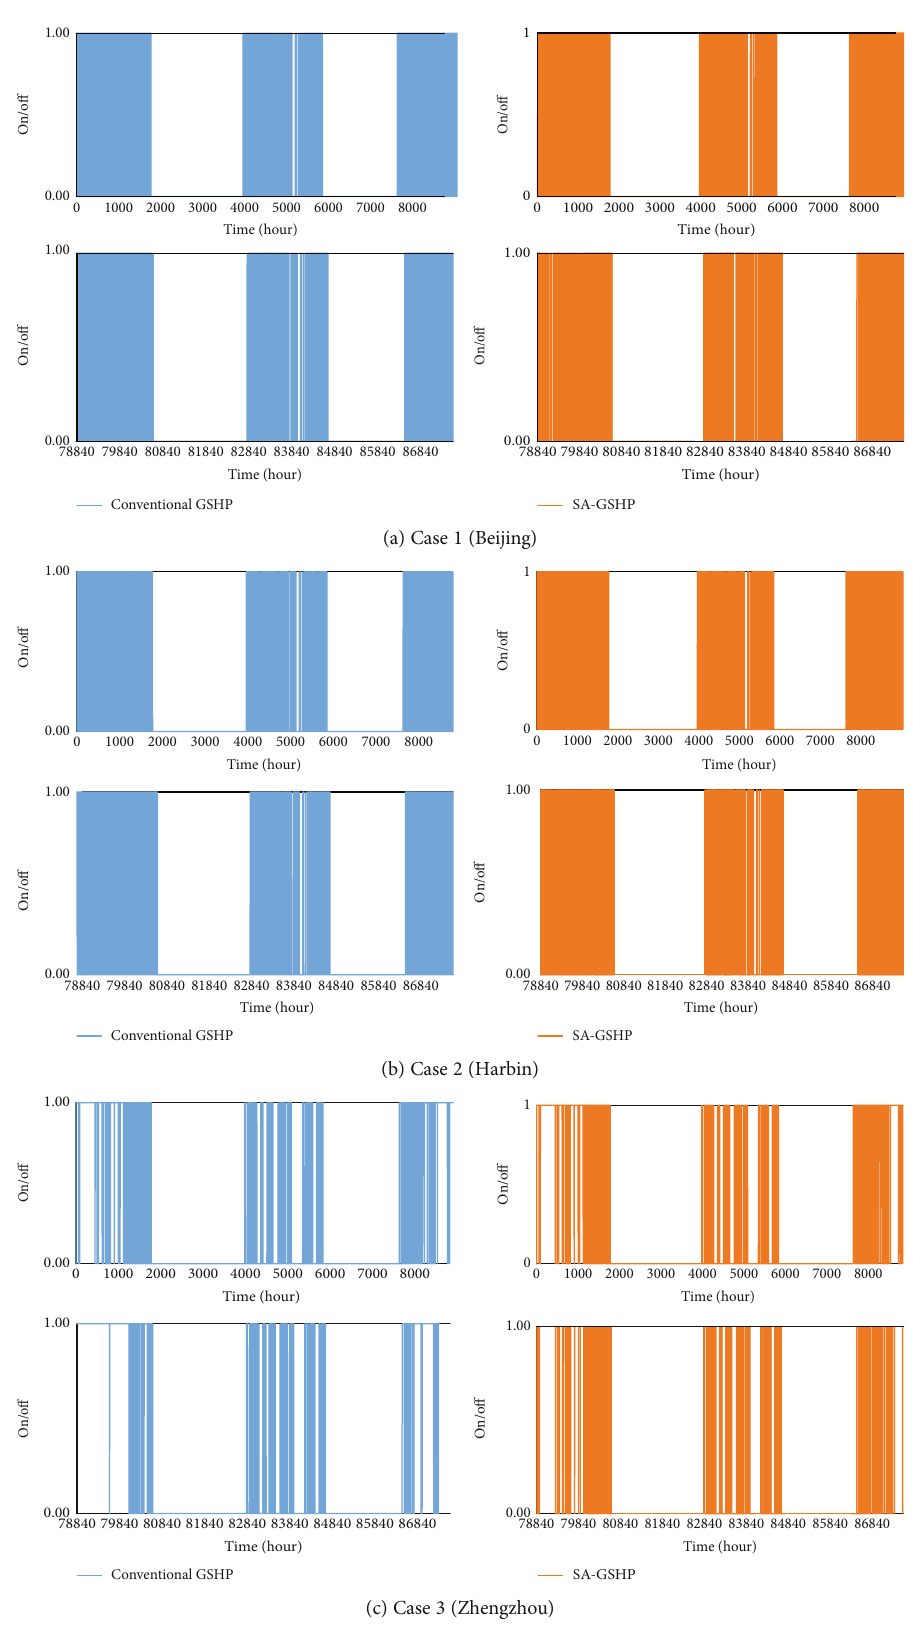
Figure 13: Ten-year trend in pump operating signal during heating for the GSHP and SA-GSHP